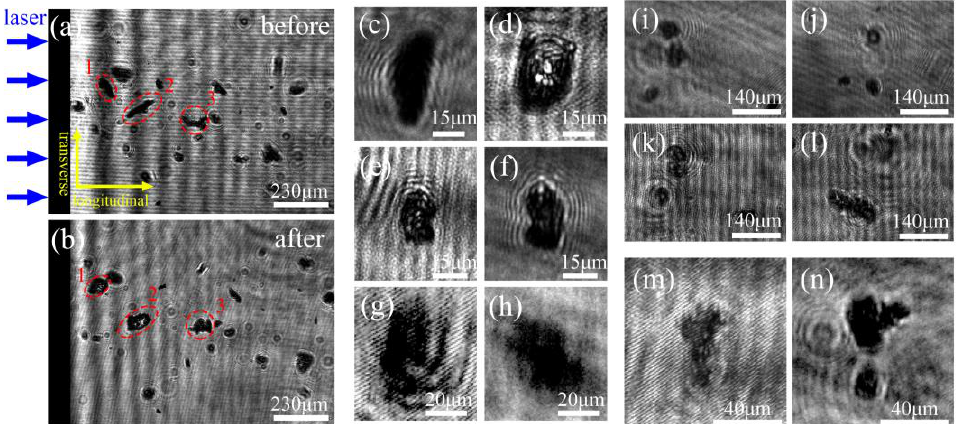
Figure 3. Transient characteristics of laser-induced particles acquired by comparing two images at different time delays at the laser fluence of 79 J/cm 2 . ( a , b ), ( i , j ), and ( k , l ) at 3,982 ns to 5,504 ns, ( c , d ), and ( e , f ) at 3,985 ns to 5,997 ns, ( g , h ), and ( m , n ) at 5,987 ns to 7,495 ns.